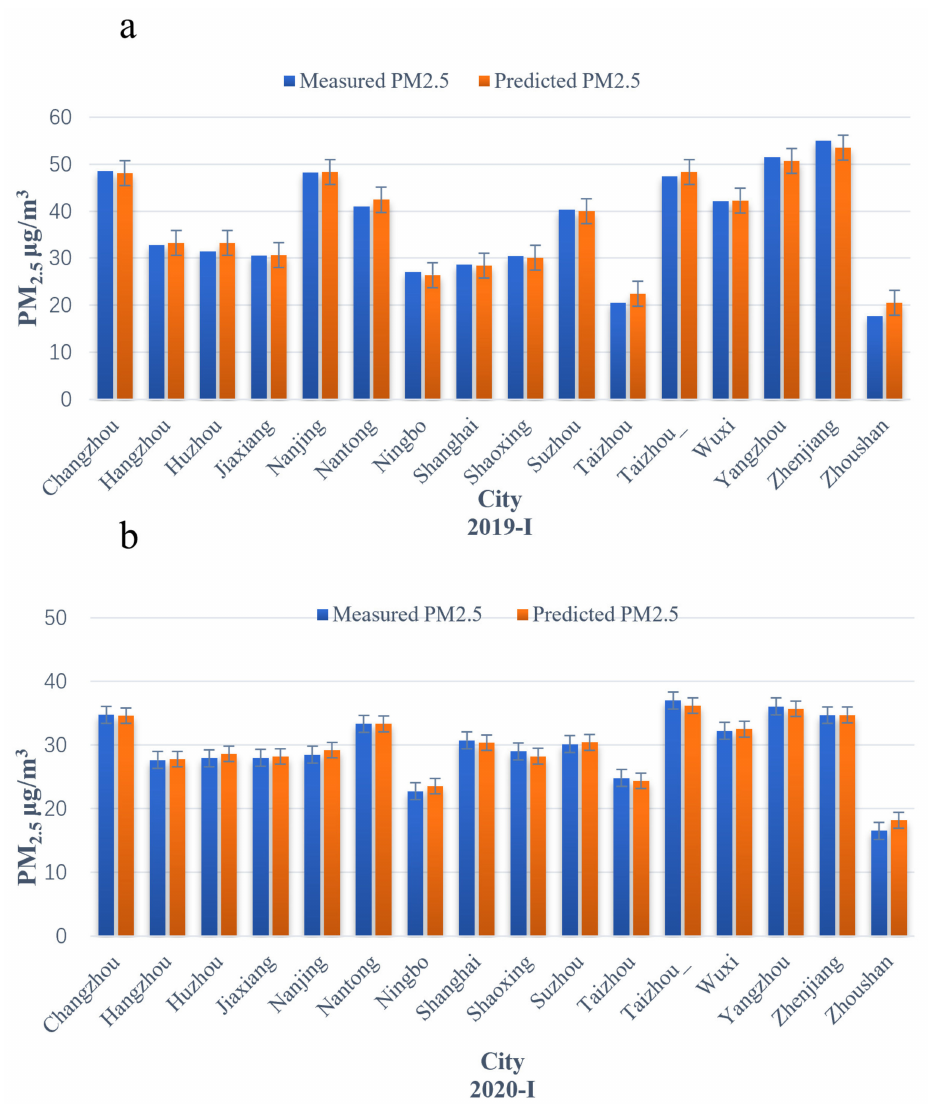
Figure 5. Regional mean measured/predicted PM 2.5 average monitored concentrations and average simulated concentration of each city ( a :2019-I; b